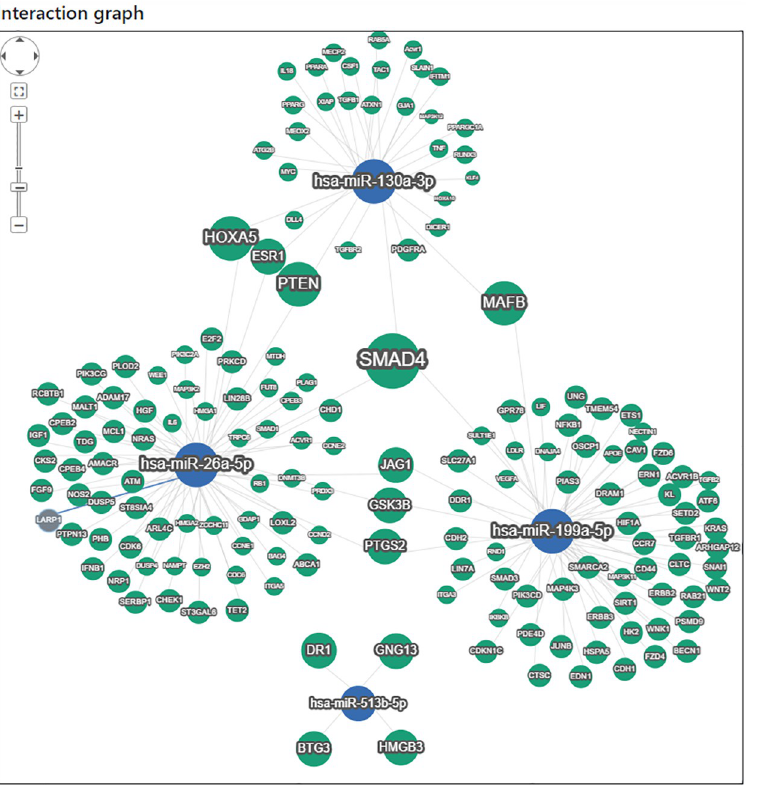
Fig 4. miRTargetLink 2.0—Interactive miRNA target gene and target pathway